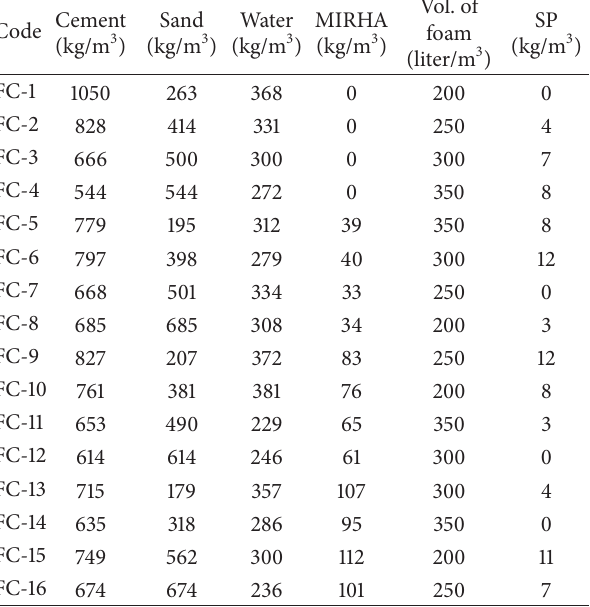
Table 4: Mixture proportion of